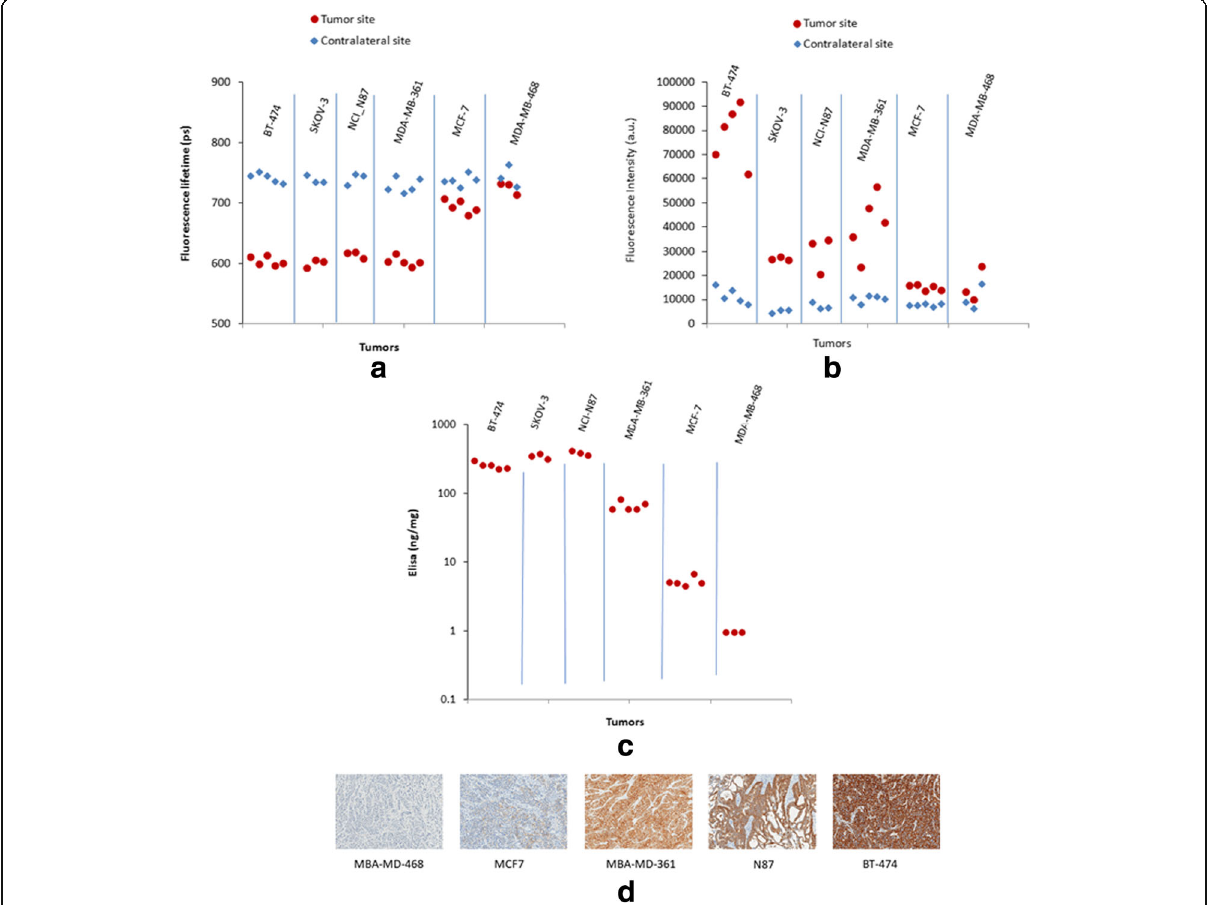
Fig. 2 a Fluorescence lifetime and b fluorescence intensity measured in vivo at the tumor and contralateral sites, 1 h after injection of HER2-specific Affibody probe. c HER2 expression in each tumor measured by ELISA after tumor extraction. d Immunohistology images of five different tumor types with different HER2 expression, extracted 24 h after injection of HER2-specific affibody, and stained using DAKO HercepTest ™ (Dako, Carpinteria,